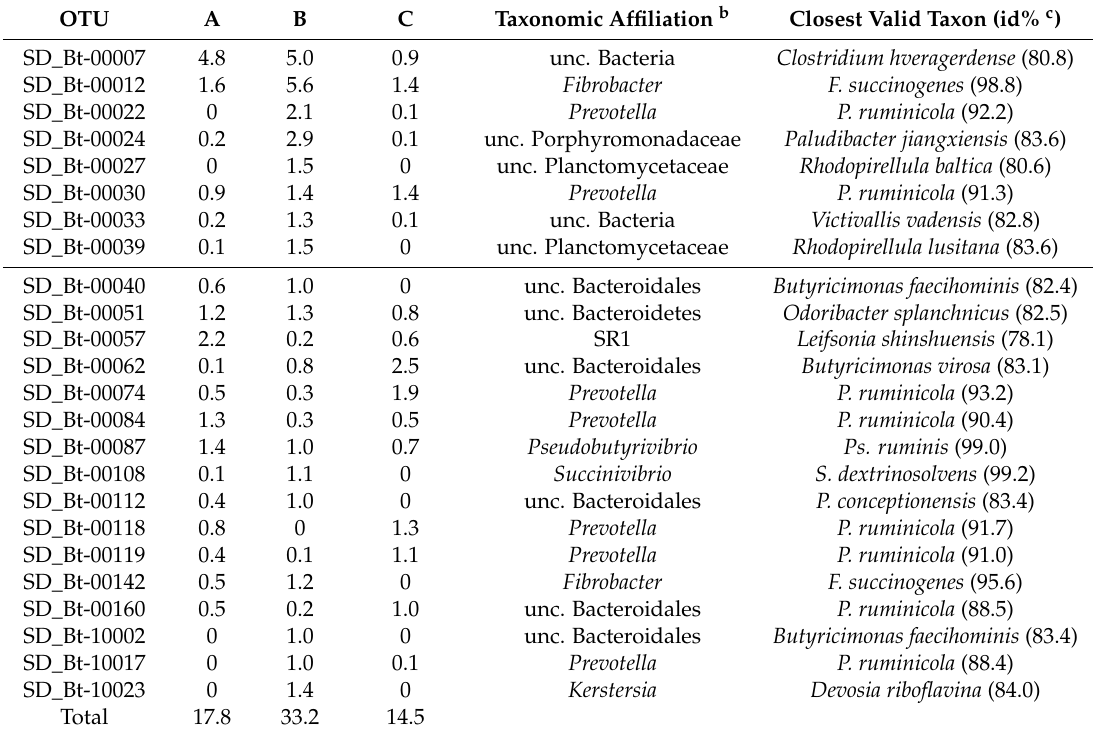
Table 2. Most abundant a rumen bacterial OTUs from three beef cows maintained on a forage diet. Representation is shown for each animal (cow A, cow B, cow C) as relative abundance, with corresponding taxonomic assignments and closest taxon also